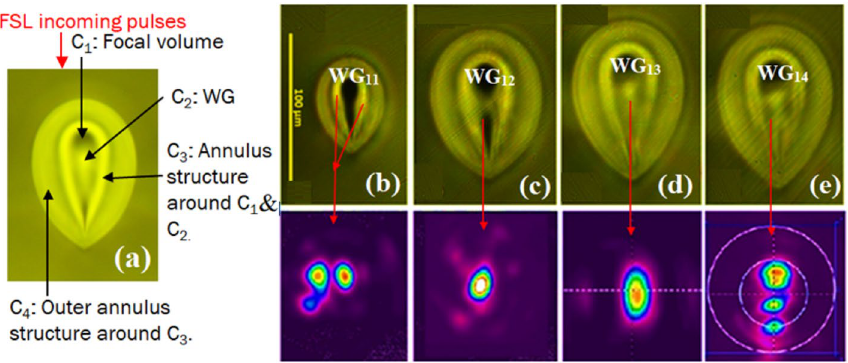
Figure 9. ( a ) 20 × Bright field microscopy image (cross-sectional view) of single line FSL modified region in 5 MHz PRF, 100 nJ pulse energy. The image illustrates the different structures of the heat accumulated region: the dark structure is the focal volume C 1 , C 2 is the bright guiding structure (WG) originating from the center of C 1 at higher pulse energies. C 3 is annulus structure with varying index layers around C 1 and C 2 . C 4 is the outer annulus structure, although bright, it is not suitable for laser applications. ( b – e ) 20 × Brightfield microscopy image of the 5 MHz FSL single line FSL modified regions with pulse energies ranging from 60 to 120 nJ with 20 nJ intervals. The bright structures in C 1 (red arrows) are the guiding structures named WG 11 –WG 14 . The 2nd row illustrates the 1550 nm beam profiles in the inscribed WGs.